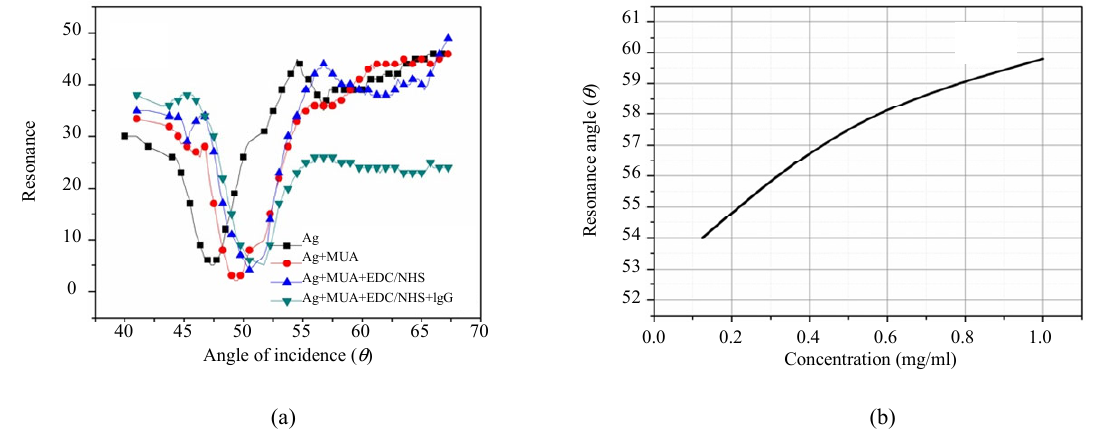
Fig. 7 SPR measurement: (a) staked layers and (b) response to venom protein.